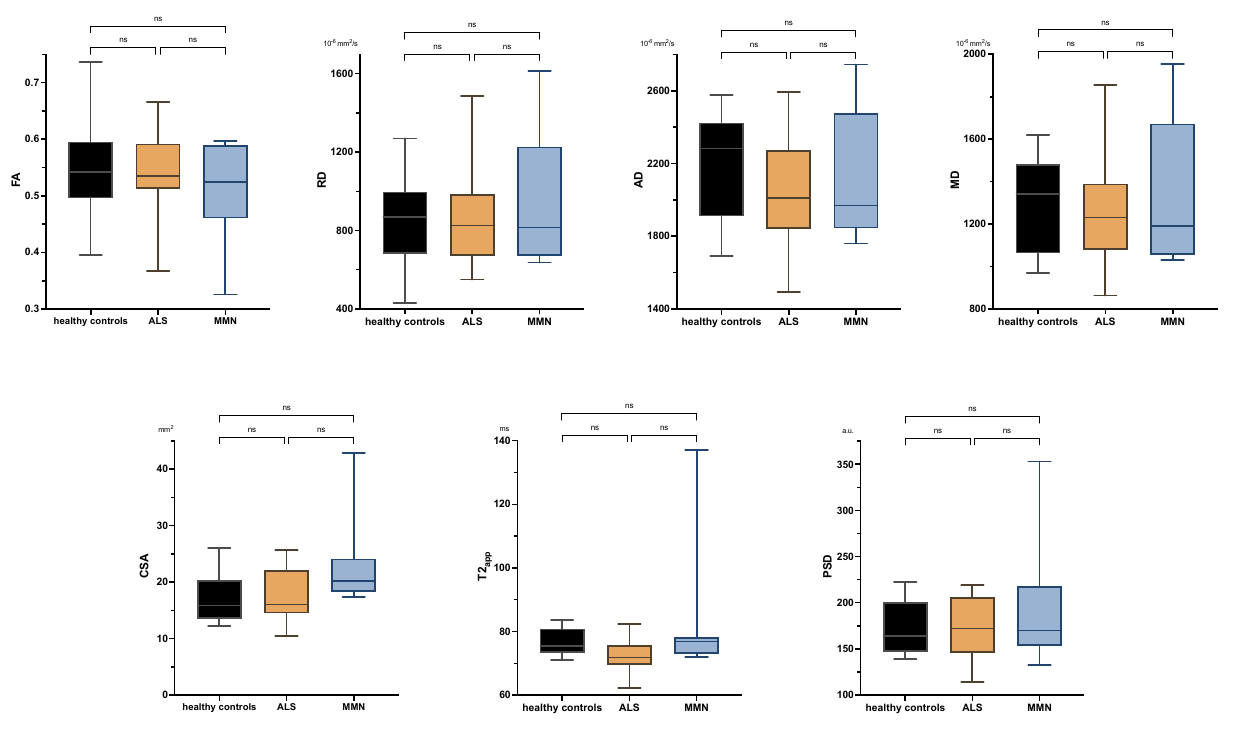
Figure 3. Boxplots of DTI parameters (upper row), cross-sectional area (CSA), and T2-relaxometry metrics (lower row) measured in the tibial nerve at the thigh. One-way analysis of variance with Holm–Sidak’s correction, statistical significance was set at p ≤ 0.05. The plots illustrate the 25–75th percentiles (boxes) and minimum-to-maximum values (whiskers). Ns, not signi fi cant.